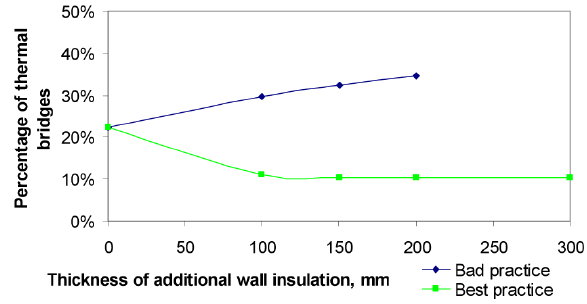
Fig. 7. Percentage of thermal bridges in transmission heat loss (through the whole building thermal envelope including thermal bridges)